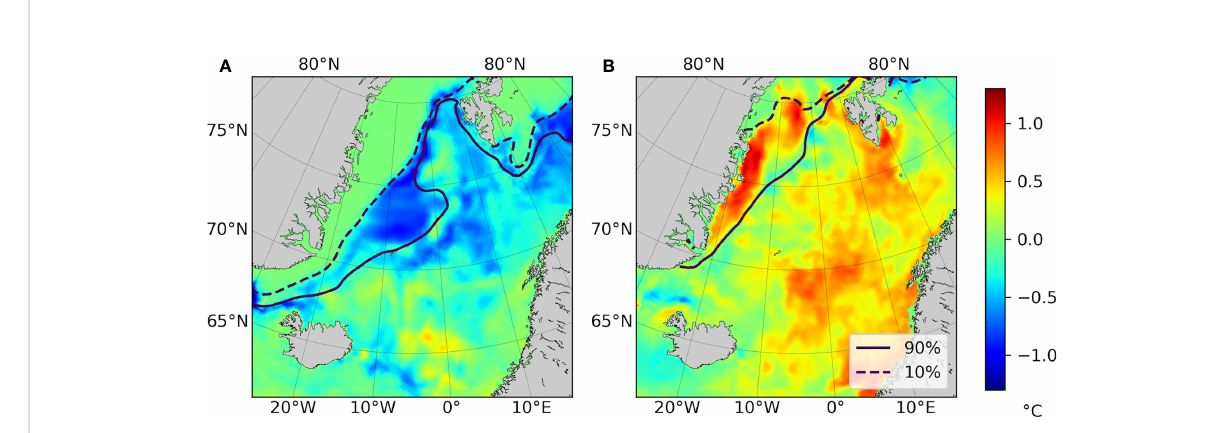
FIGURE 10 Composite map of sea temperature anomaly when percentile of the sea ice extent in (A) February-March is above 90% and (B) August- September is under 10%. The solid (dashed) contour lines represent the sea ice edge when the percentile of ice extent is 90% (10%) for each